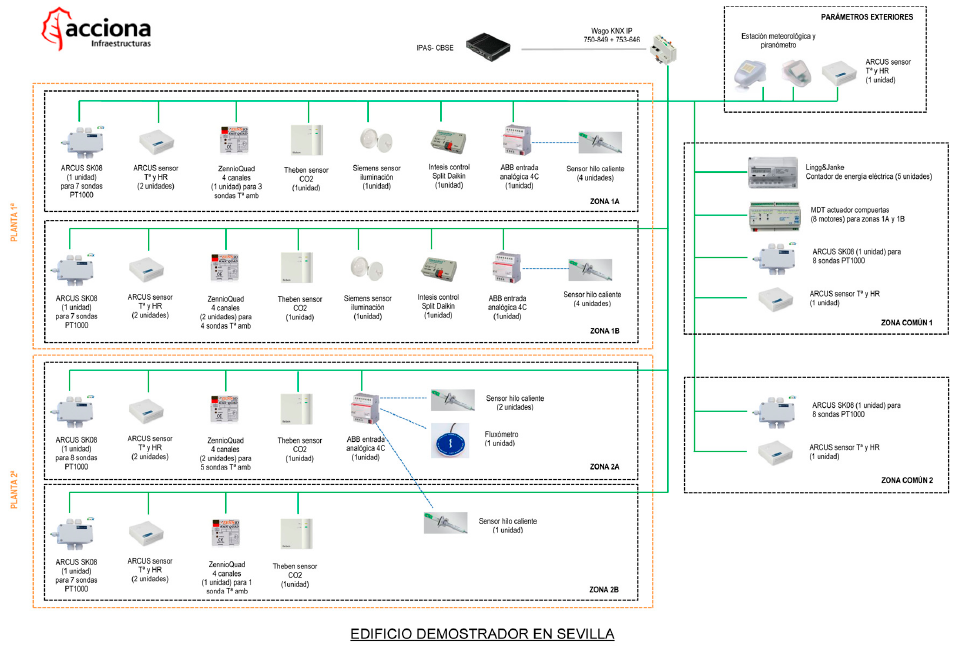
Figure 7. General schema of the installation in the Seville building. One can see the first roof (1A) and the second floor (2A), and the different installations used to control the building.